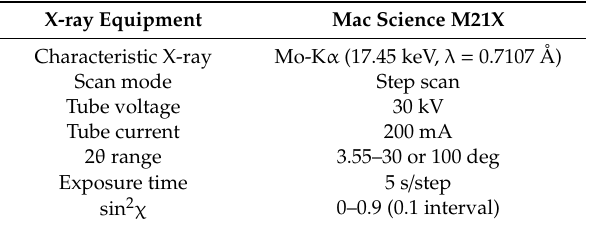
Table 1. X-ray conditions for measurement of X-ray elastic